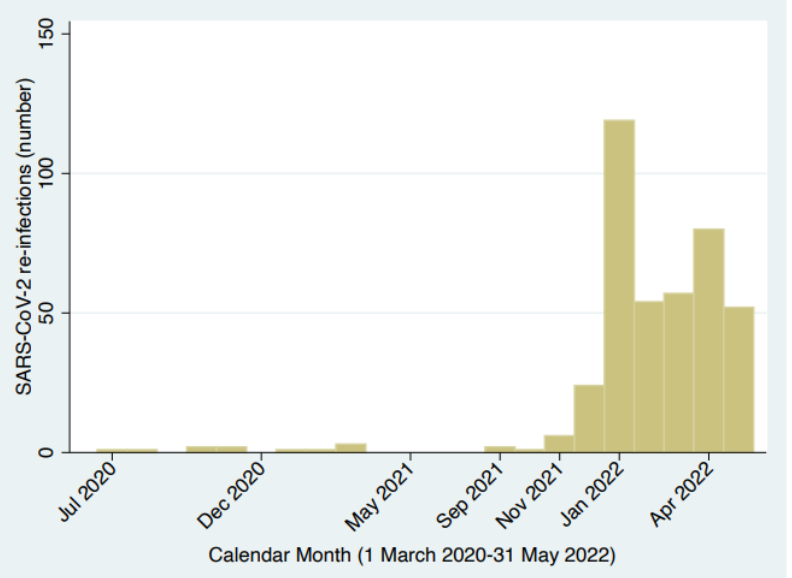
Figure 3. Number of SARS-CoV-2 re-infections (Total = 406) in health care workers (HCWs) of ASUGI, by calendar month, 1 March 2020 – 31 May 2022.